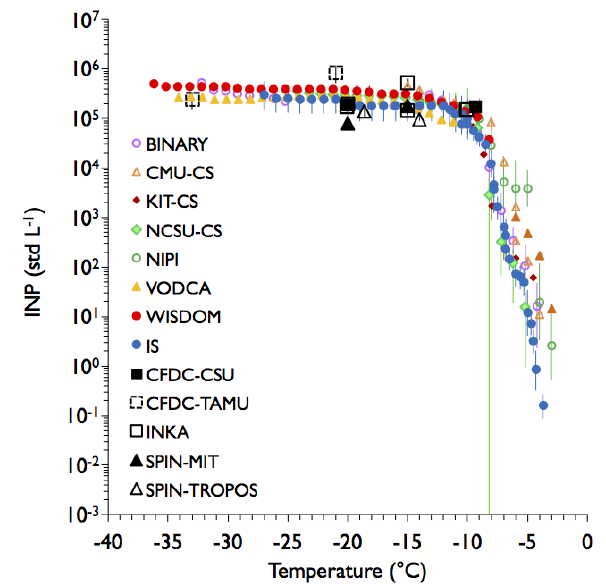
Figure 7. As in Fig. 4, but for sampling of aerosolized Snomax ® particles from the APC. Two sets of measurements are plotted sepa- rately from the CMU-CS system (open and filled) due to variability observed between replicate samples as discussed in the text. The closed orange triangles are from experiments run immediately after the sample had thawed, while the open triangles are for runs that oc- curred within a few hours of thawing. In this case, all post-processed data are from the impinger sample. INKA data are included for all water supersaturated conditions not exceeding water breakthrough RH w . The data herein correspond to FIN-02 APC experiments 15 and 16 on 20 March